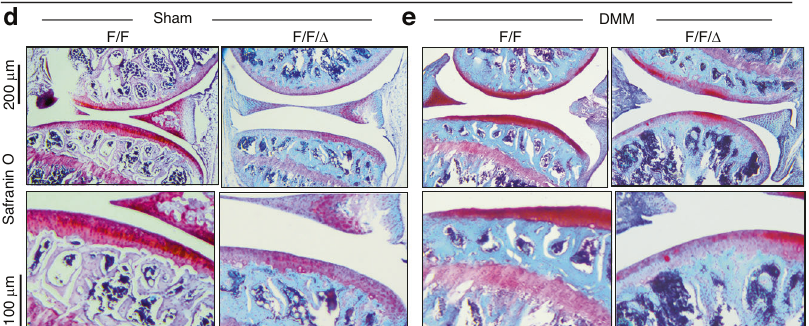
Fig. 1 Loss of Runx1 in chondrocytes exacerbated articular cartilage damage after DMM surgery. a Western blot of knee joints from 4.5- month-old Runx1 f/f (F/F) and Runx1 f/f Col2 α 1-Cre (F/F/ Δ ) mice. b Safranin O (SO) staining for hip joint. c Anti-Runx1 immunohistochemistry (IHC) staining of the hip joint of 3- and 4-month-old mice. d , e Safranin O (SO) staining of the knee joint of 3-month-old mice after ( d ) sham and ( e ) DMM surgery. f Knee joint and hip joint OARSI scores of ( d and e ). The results are presented as the mean ± SD, n = 3, * P < 0.05, ** P <